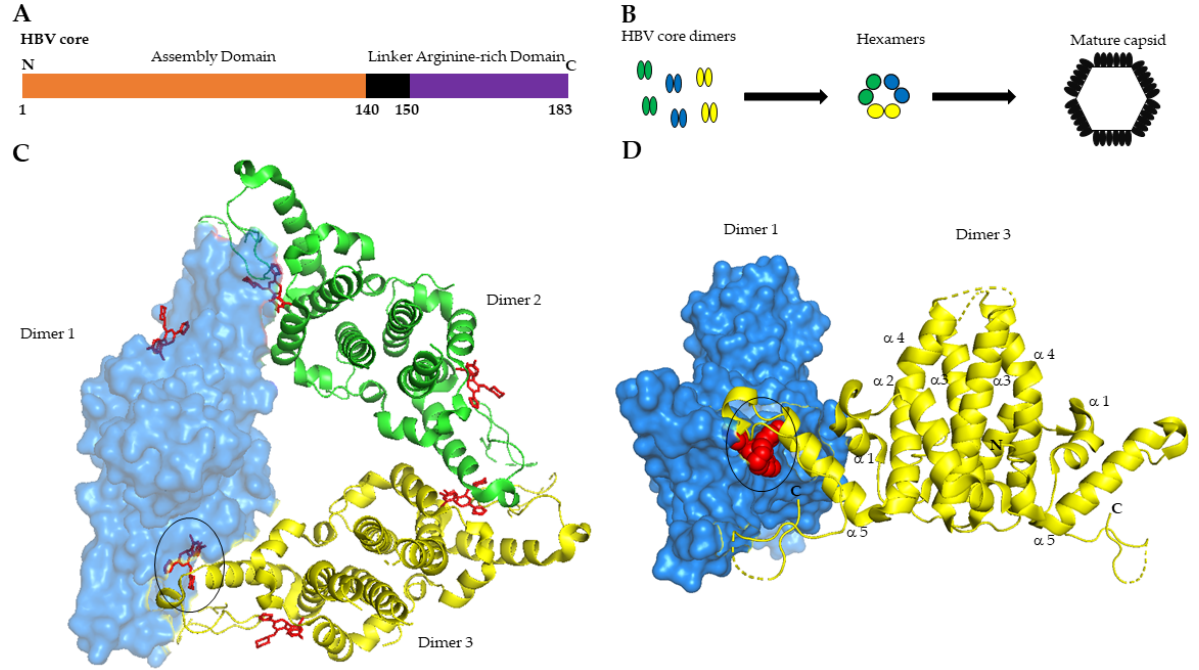
Figure 1. HBV core protein N-terminal domains 3D structure and capsid assembly process. ( A ) Schematic representation of HBV core domains N-terminal: N. C-terminal: C; ( B ) Steps of capsid assembly process; ( C ) Cristal structure of core protein hexamer with six bound NVR-010–001-E2 molecules shown in red. The structure has been adapted from the deposited 3D structure of HBV core mutant Y132A on PDB database (PDB: 5e0i; Lukacs, C.M., Abendroth, J., Klumpp, K., Crystal structure of the HBV capsid Y132A mutant (VCID 8772) in complex with NVR10-001E2 at 1.95A resolution, doi: 10.2210/pdb5e0i/pdb) [19]. Core dimers are colored respectively in blue (dimer 1), green (dimer 2), yellow (dimer 3). Dimer 1 is shown in surface mode. ( D ) Front view of dimer 1 and dimer 3 complex. Dimer 1 is shown as surface mode. ( C , D ) CAM molecule NVR-010–001-E2 bound at the dimer 1 and dimer 3 interface is encircled in black. The structure was designed using PyMOL, Version 2.5.2, Schrödinger, LLC.